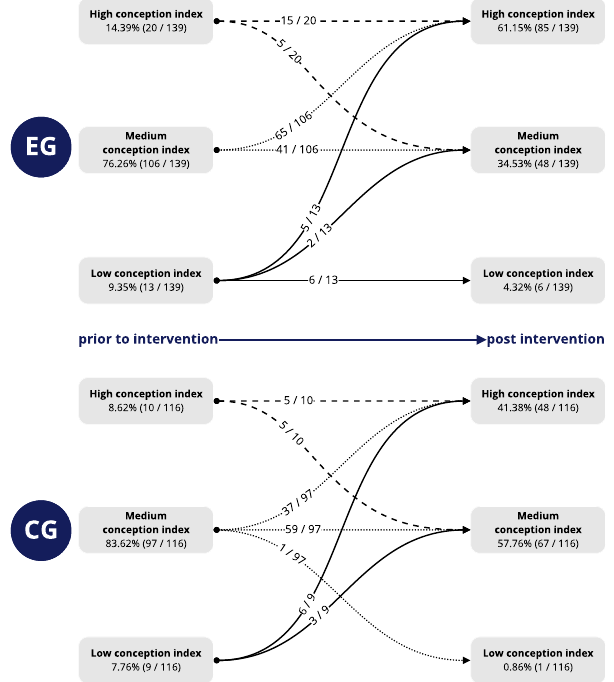
8. Students ’ transitions between high (HC), medium (MC), and low (LC) conception index groups from pre- to post-test based on the students ’ results on the quantum objects ’ properties and behavior scale. It is shown which number of students from each of the pretest groups HC, MC, and LC change to which group at the post-test point in time. For both survey time points, it is also indicated how many students are assigned to the three groups in total, for both EG and